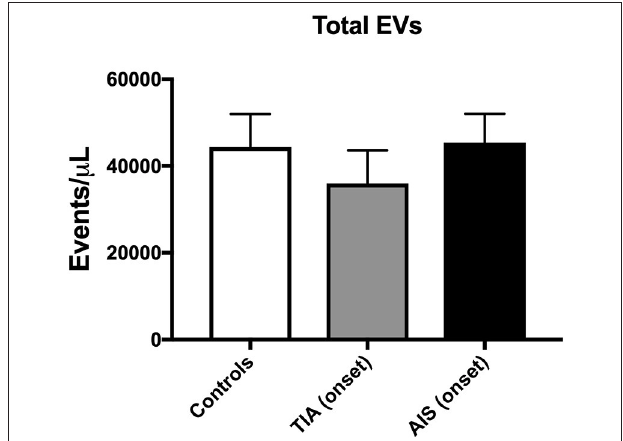
FIGURE 1 | Circulating total EV levels, at onset of attacks, in patients with TIA and AIS compared to healthy controls. Histograms represent events/ µ L in plasma poor in platelets (PFP) expressed as mean ± SEM. Controls, n = 24; TIA, n = 21; AIS, n = 66.